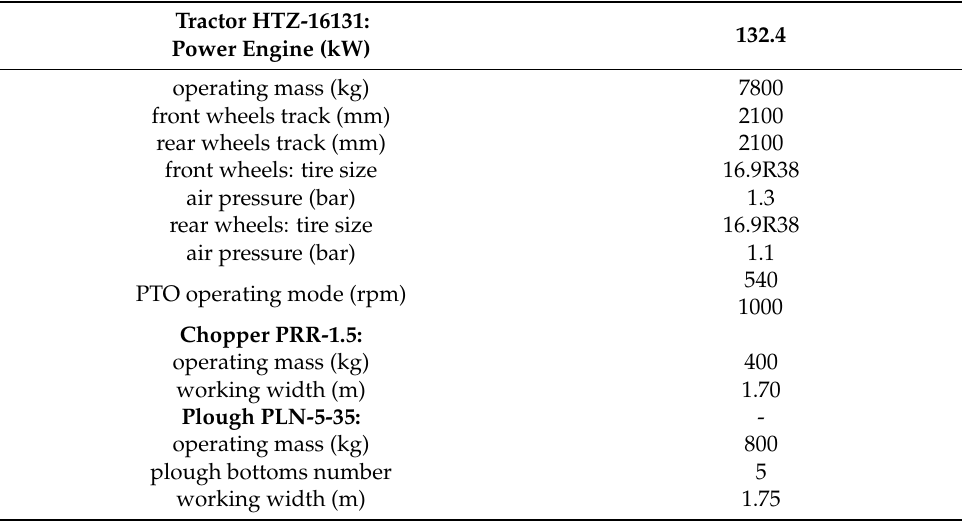
Table 1. Technical characteristic of the plow-chopping